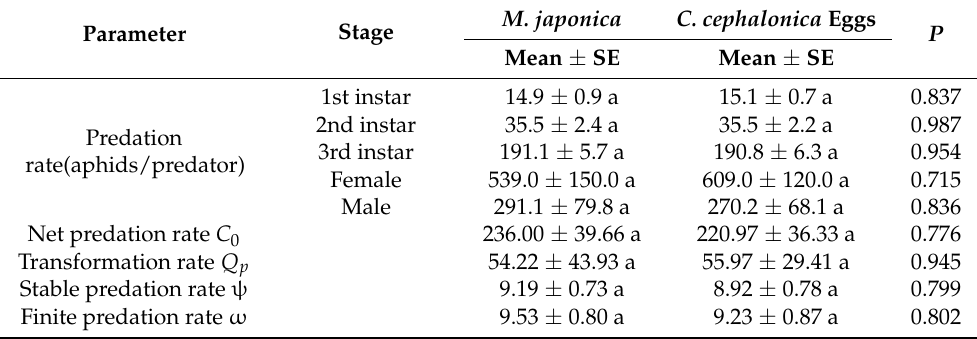
Table 3. Predation rates and parameters of Chrysopa pallens ever cultured on Megoura japonica and Corcyra cephalonica eggs fed on Aphis craccivora under fluctuating temperature conditions in a greenhouse (paired bootstrap test, B = 100,000, the same lowercase letters in the same column indicate the values are not significantly different, P > 0.05). Parameter Stage